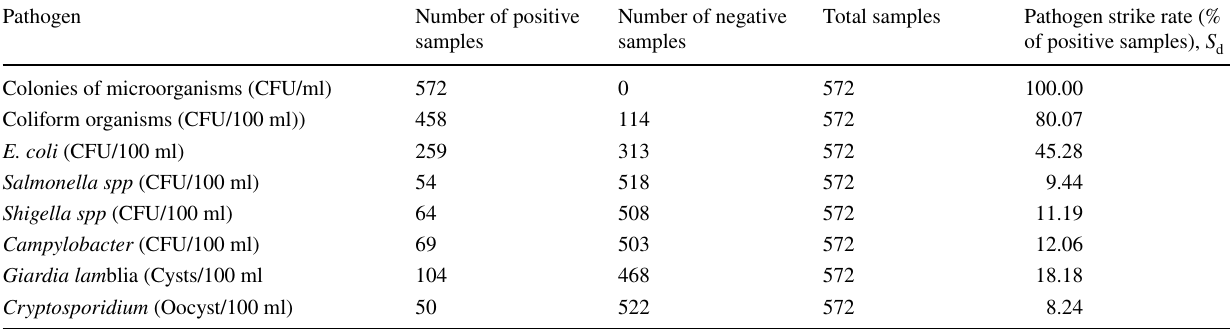
Table 7 Pathogen strike rate Pathogen